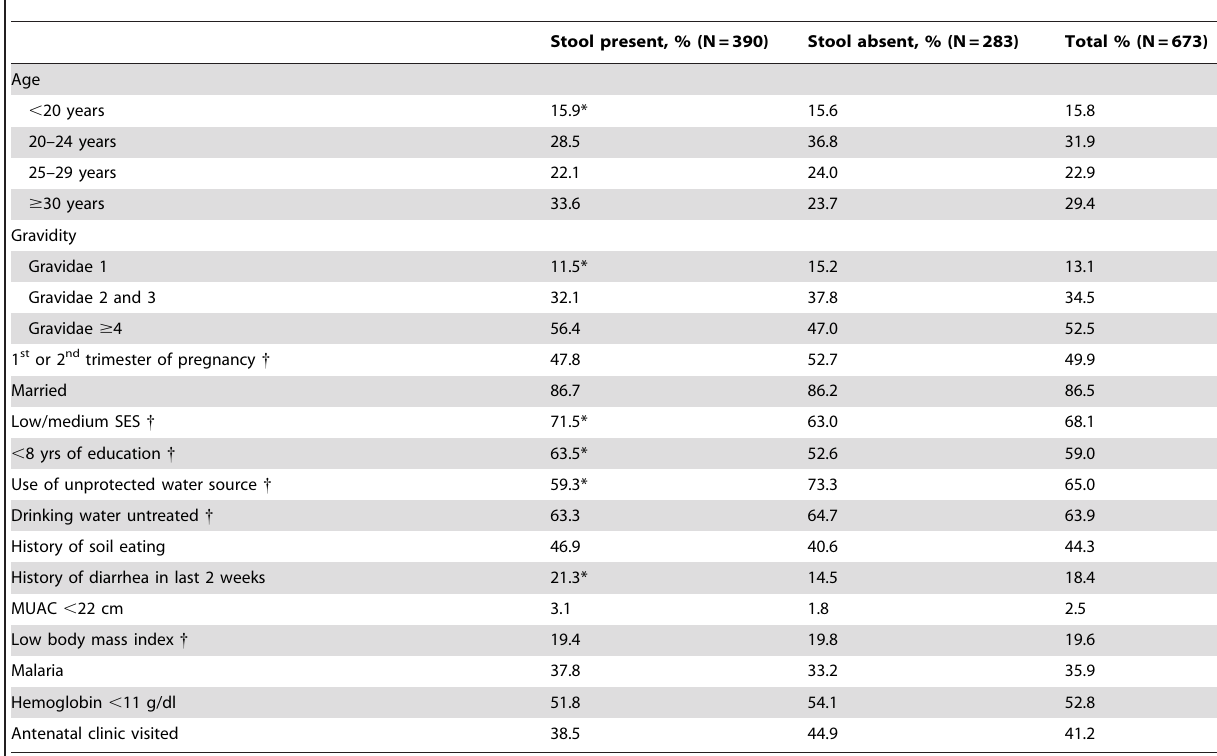
Table 1. Characteristics of the participating pregnant women by presence of a stool sample result, Gem, July 2003.